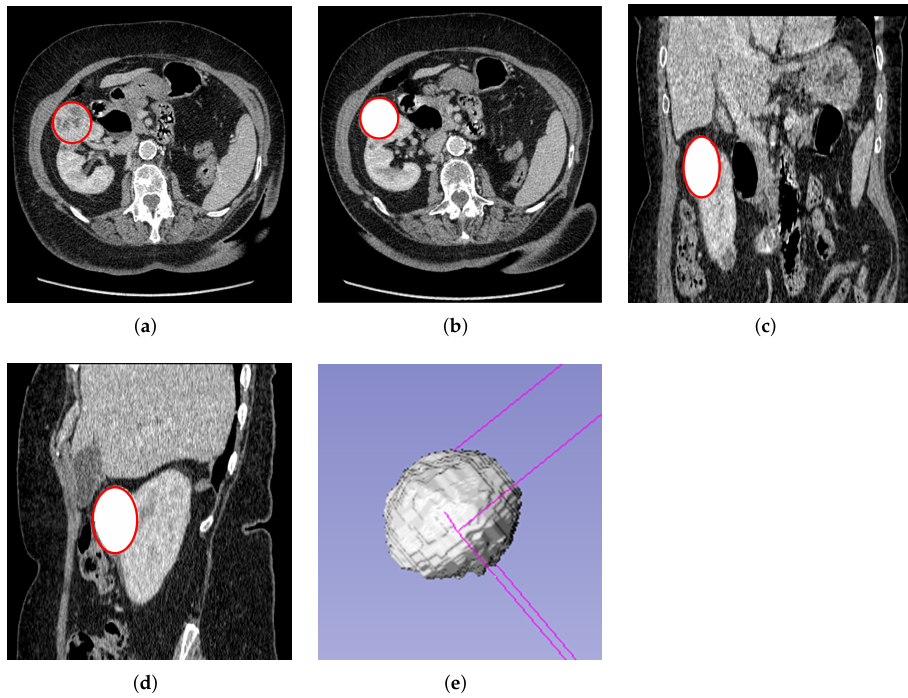
Figure 2. Semi-automatic 3D slice tumor segmentation using the volume editor of the slicer 3D software. ( a ) Original axial plane of the 3D image with VOI. ( b ) Segmented axial tumor plane mask from the kidney. ( c ) Segmented tumor mask of coronal plane. ( d ) Segmented tumor mask of sagittal plane. ( e ) 3D segmentation volume